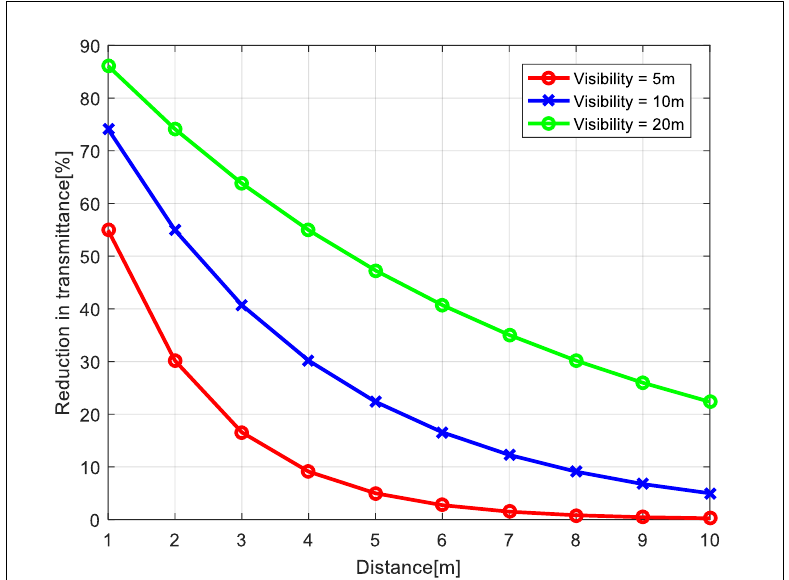
Figure 15. The decrease in transmittance as the distance between the sensor and the object